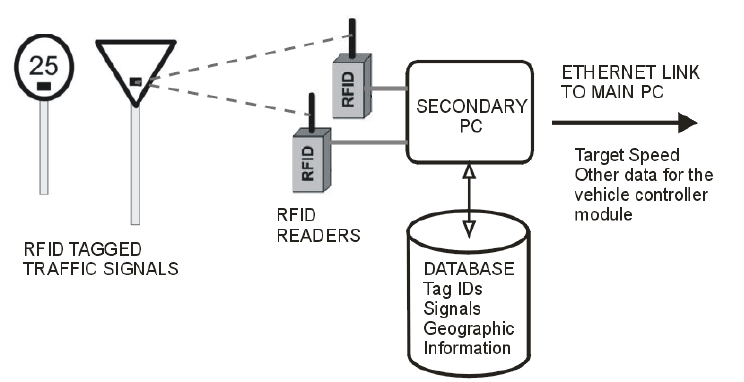
Figure 3. Operational block diagram of the RFID